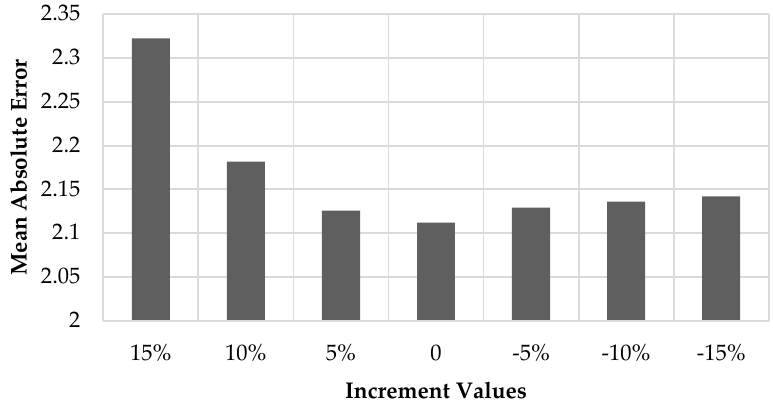
Figure 4. Mean absolute error (MAE) results of different values of age incrementation as compared to the base dataset with 0% incrementation.